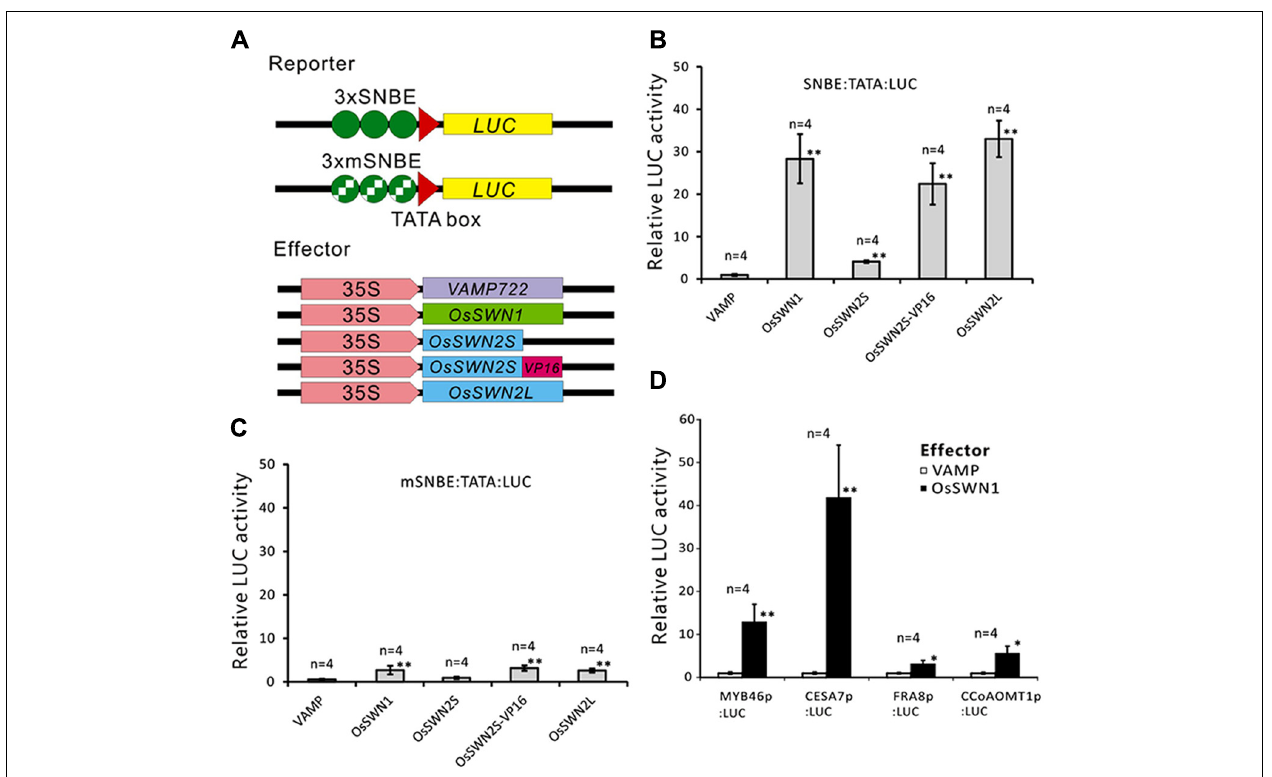
FIGURE 3 | OsSWN1 and OsSWN2L but not OsSWN2S can activate transcription . (A) Schematic of constructs used in the reporter-effector transient assay in Arabidopsis leaf protoplasts. “SNBE” and “mSNBE” represent the binding sequence for NST transcription factors and a mutated version of the binding site, respectively. “LUC” represents firefly luciferase, which was used as the reporter in this experiment. VAMP722, which localizes to the vacuolar membrane (Uemura etal., 2004), was employed as the negative control. (B, C) Relative LUC activity of the